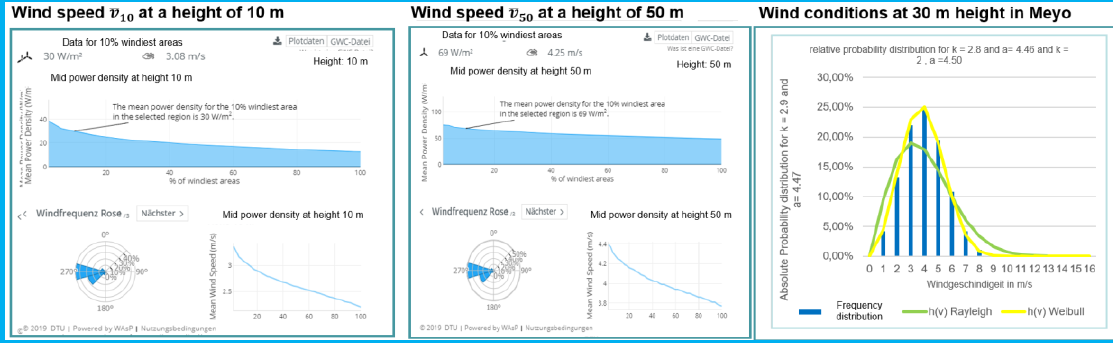
Figure 4 . Wind conditions of the operating site